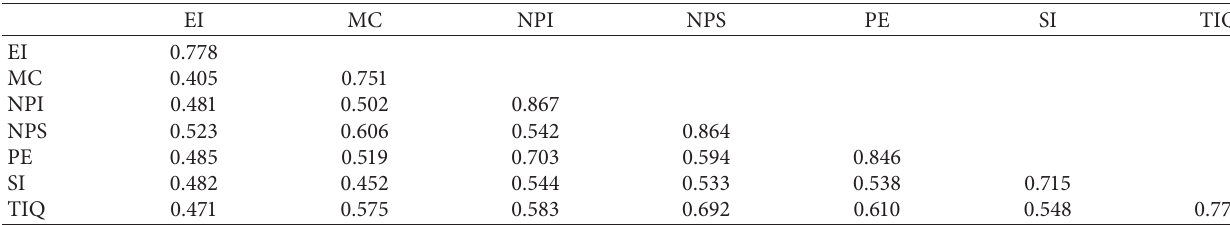
Table 2: Fornell-Larcker.